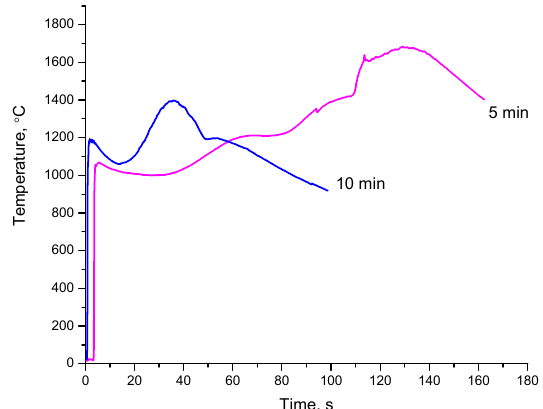
Figure 6. Thermograms of the SHS processes in the Ti+0.3C mixture ball-milled for 5 min and 10 min, combustion in nitrogen.